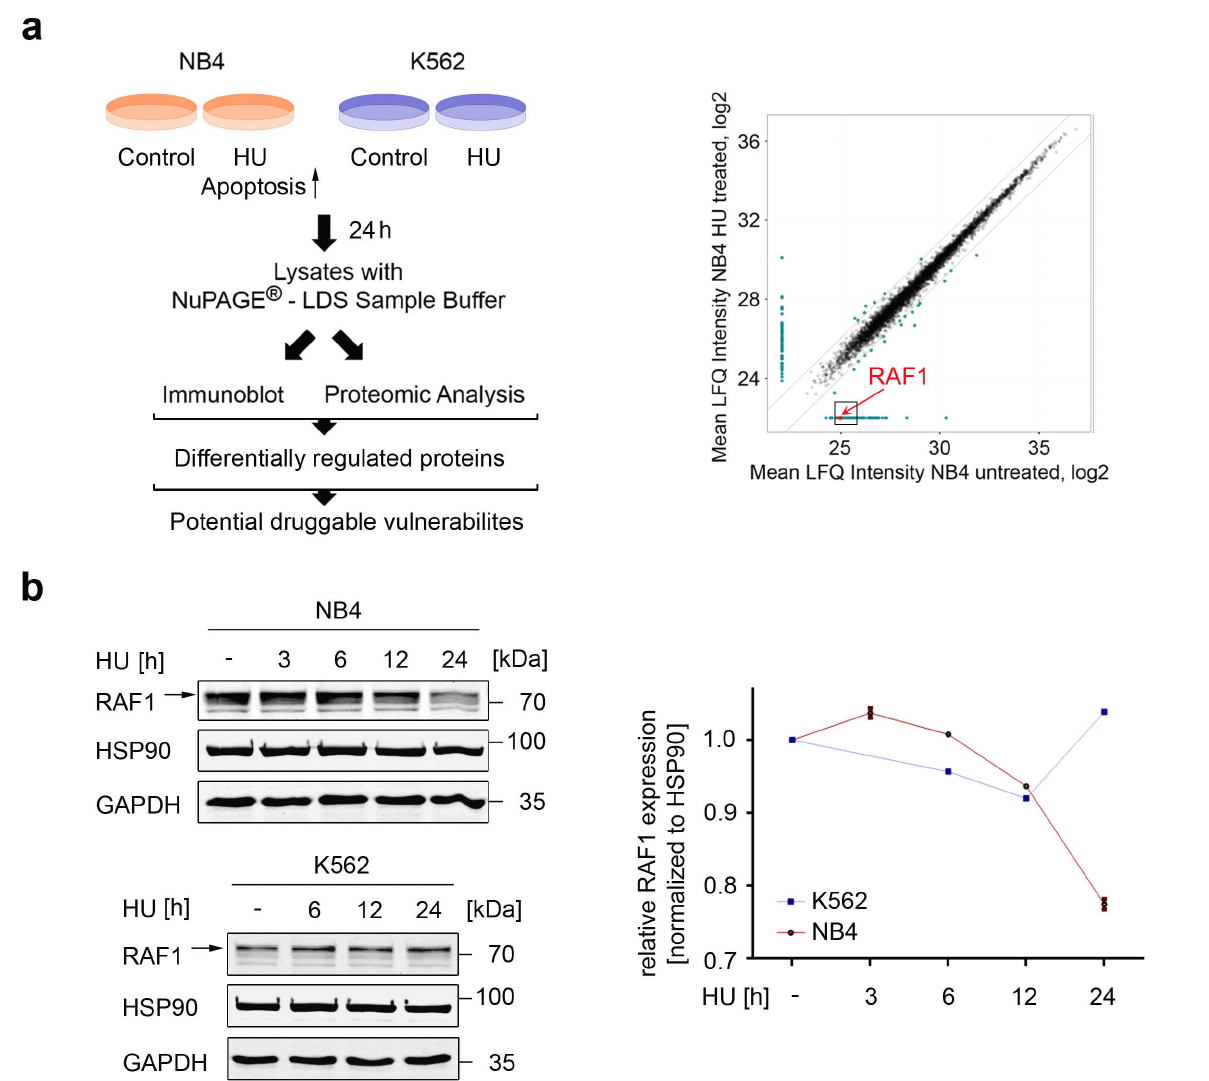
Figure 1. Downregulation of RAF1 in leukemic cells that are sensitive to hydroxyurea. ( a ) Left: Scheme of how NB4 and K562 cells were treated with 0.5 mM hydroxyurea (HU) for 24 h. Aliquots of the cells were taken to perform immunoblot analysis and global proteomics. Right: Global-scale proteomics of NB4 cells after a 12 h treatment with 0.5 mM HU. Scatter plot shows treated versus untreated cells. RAF1 was strongly reduced upon treatment; n = 3; p = 0.0003. ( b ) Left: Immunoblot of lysates from NB4 cells treated with 0.5 mM HU for 3–24 h and of K562 cells treated with 0.5 mM HU for 6–24 h shows RAF1. Arrows point to the indicated protein. Bands below 70 kDa are non-specific bands (see https: //www.proteinatlas.org/ENSG00000132155-RAF1, accessed on 29 April 2021). HSP90 and GAPDH serve as independent loading controls that were applied to the same membrane. Right: Densiometric evaluation of relative RAF1 protein expression in HU-treated NB4 and K562 cells. Values were normalized to HSP90; the untreated control is set as 1; n = 2 ±